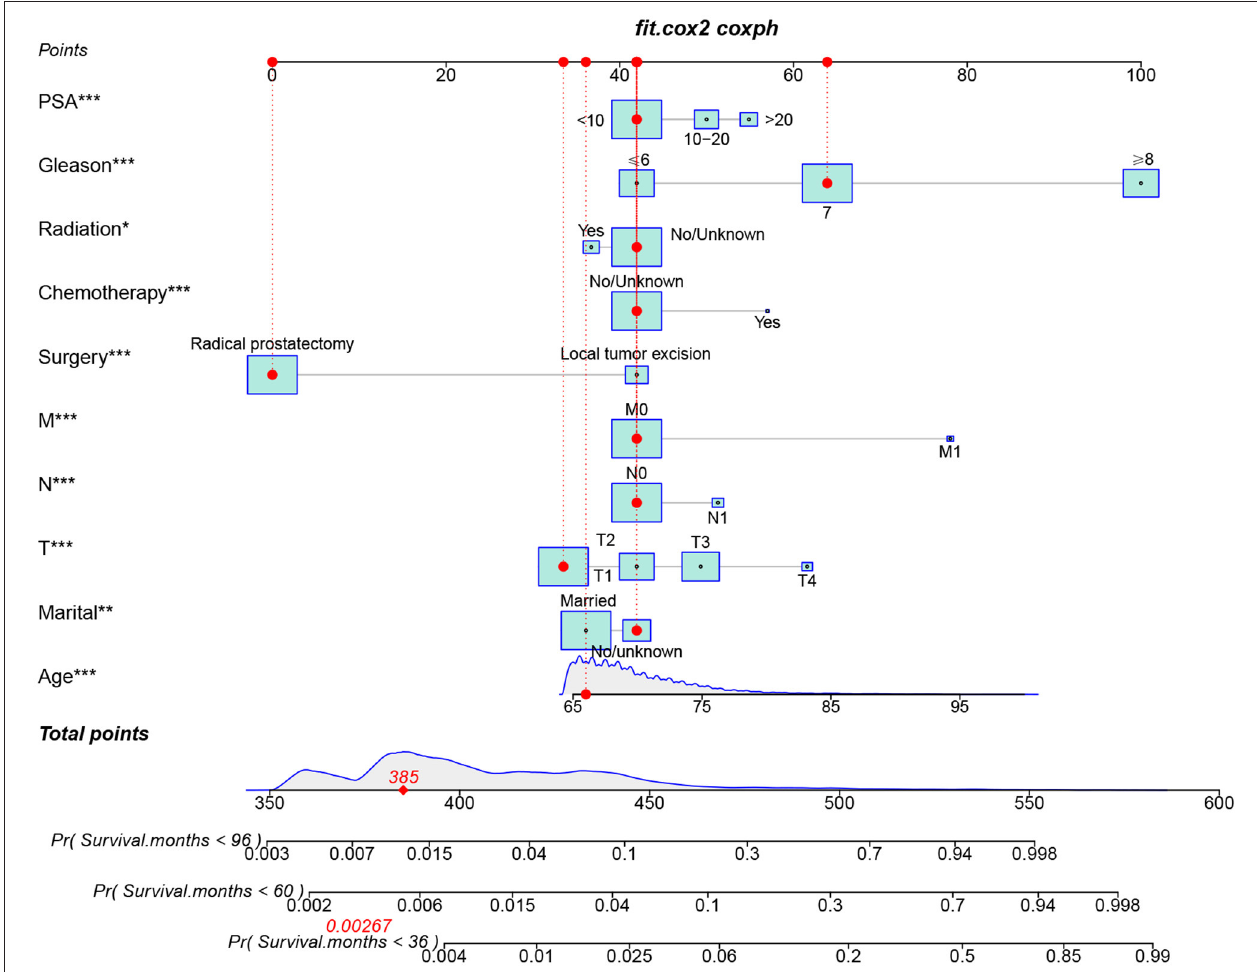
FIGURE 2 | The nomogram for predicting 3-, 5-, and 8-year CSS in elderly PC patients undergoing surgery